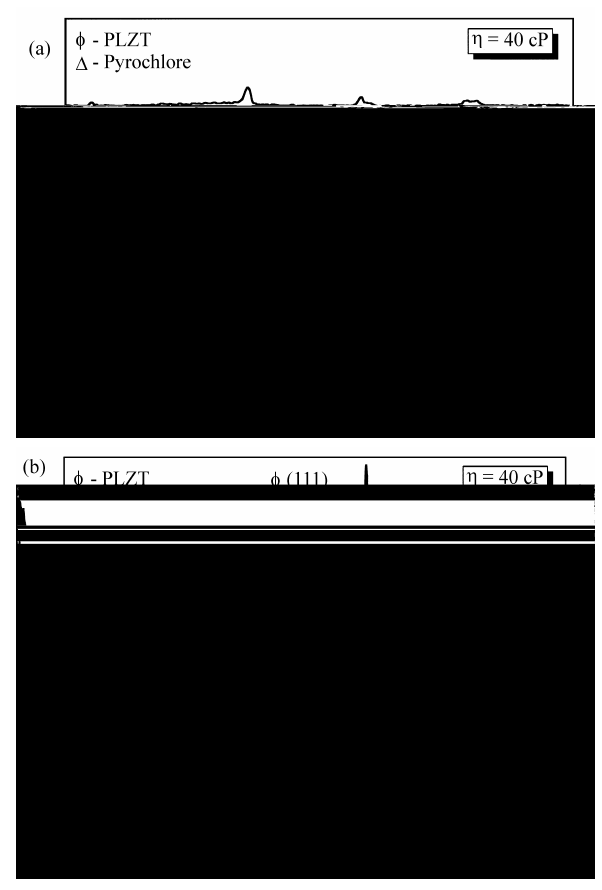
Figure 1. XRD patterns of PLZT films ( η = 40 cP) deposited on Si (100) substrate and annealed at 650 °C for 3 h in differents atmospheres: (a) air and (b)